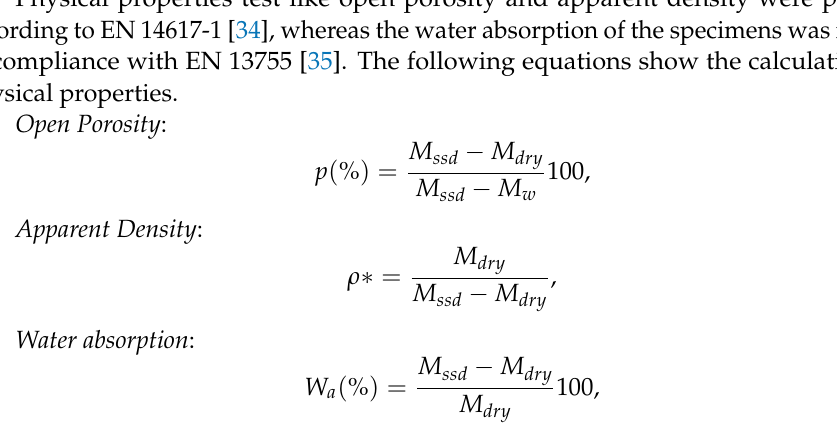
Figure 11. Compressive and flexural strengths of the tested